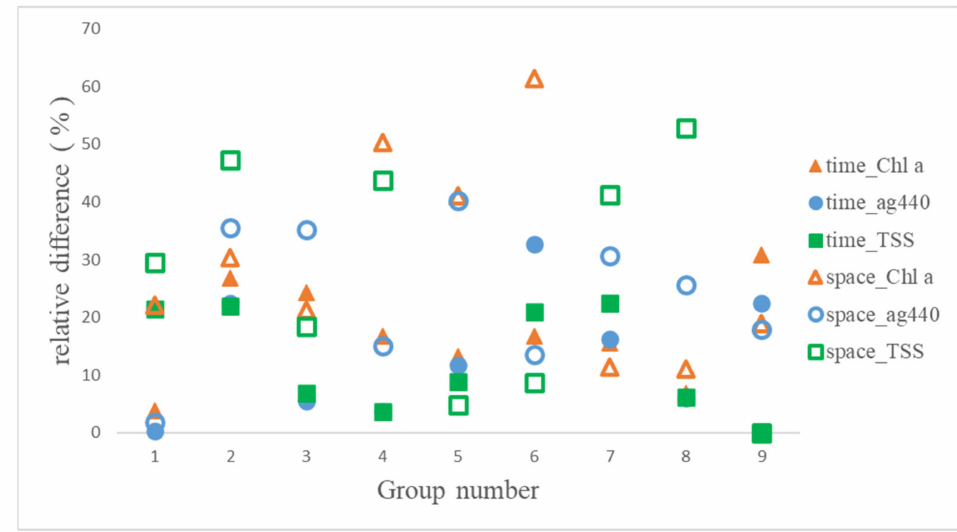
Figure 11. Relative differences in space/time transition. Relative differences are displayed in different colors for three parameters of Chl a , ag 440 , and TSS. The hollow and solid symbols represent the relative differences of each parameter impacted by space mainly or time